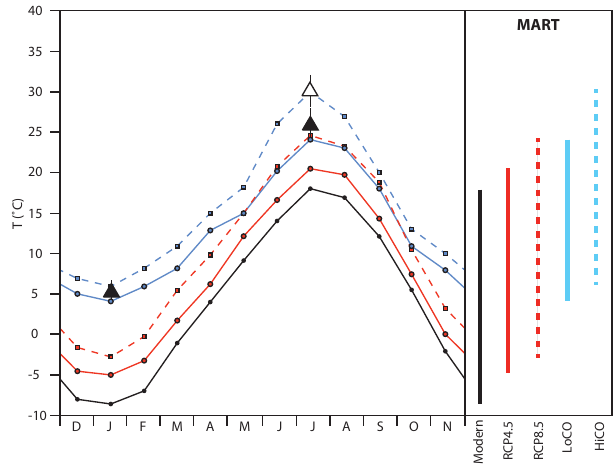
Figure 5. Averaged monthly mean temperatures in the GRB, in- cluding: modern instrumental data (filled black circles; NCDC, 2010); high (red squares; RCP8.5) and low (red circles; RCP4.5) future emissions scenarios (PCDMI, 2014); high (blue squares; HiCO) and low (blue circles; LoCO) early Eocene p CO 2 scenar- ios (Thrasher and Sloan, 2009, 2010); and proxy reconstructions of WMMT and CMMT for non-peak (filled triangles) and peak EECO (open triangles) from this study. Method-averaged MART estimates shown for each category (symbols and colors match the main